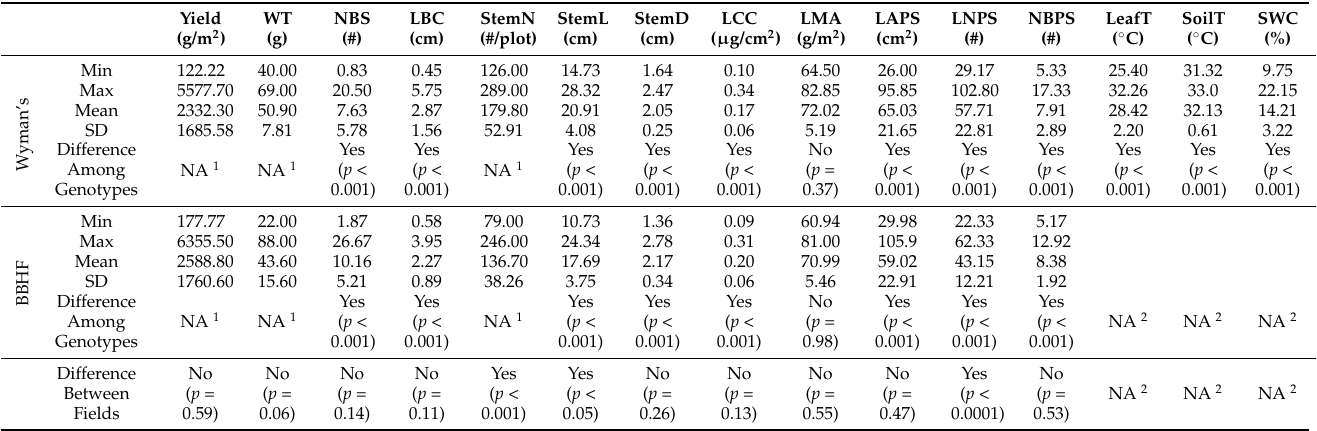
Table 2. Comparison between Jasper Wyman & Son Blueberry Farm (Wyman’s) and from Blueberry Hill Farm (BBHF) blueberry fields in yield-related, morphological, and functional traits in the minimum (Min), maximum (Max), mean, and standard deviation (SD) of Yield, WT, NBS, LBC, StemN, StemL, StemD, LCC, LMA, LAPS, LNPS, NBPS, LeafT, SoilT, and SWC. To determine trait differences between the two fields and genotypes within fields, we used a hierarchical nested mixed model with field as the fixed effect and genotype nested with-in field as the random effect. LeafT, SoilT, and SWC data were only available for the Wyman’s field. For definitions of trait abbreviations, please see Table